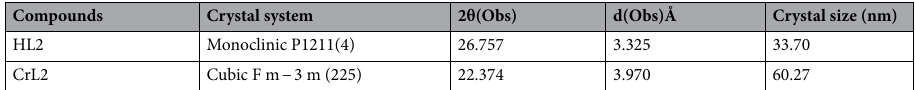
Compounds Crystal system 2θ(Obs) d(Obs)Å Crystal size (nm) HL2 Monoclinic